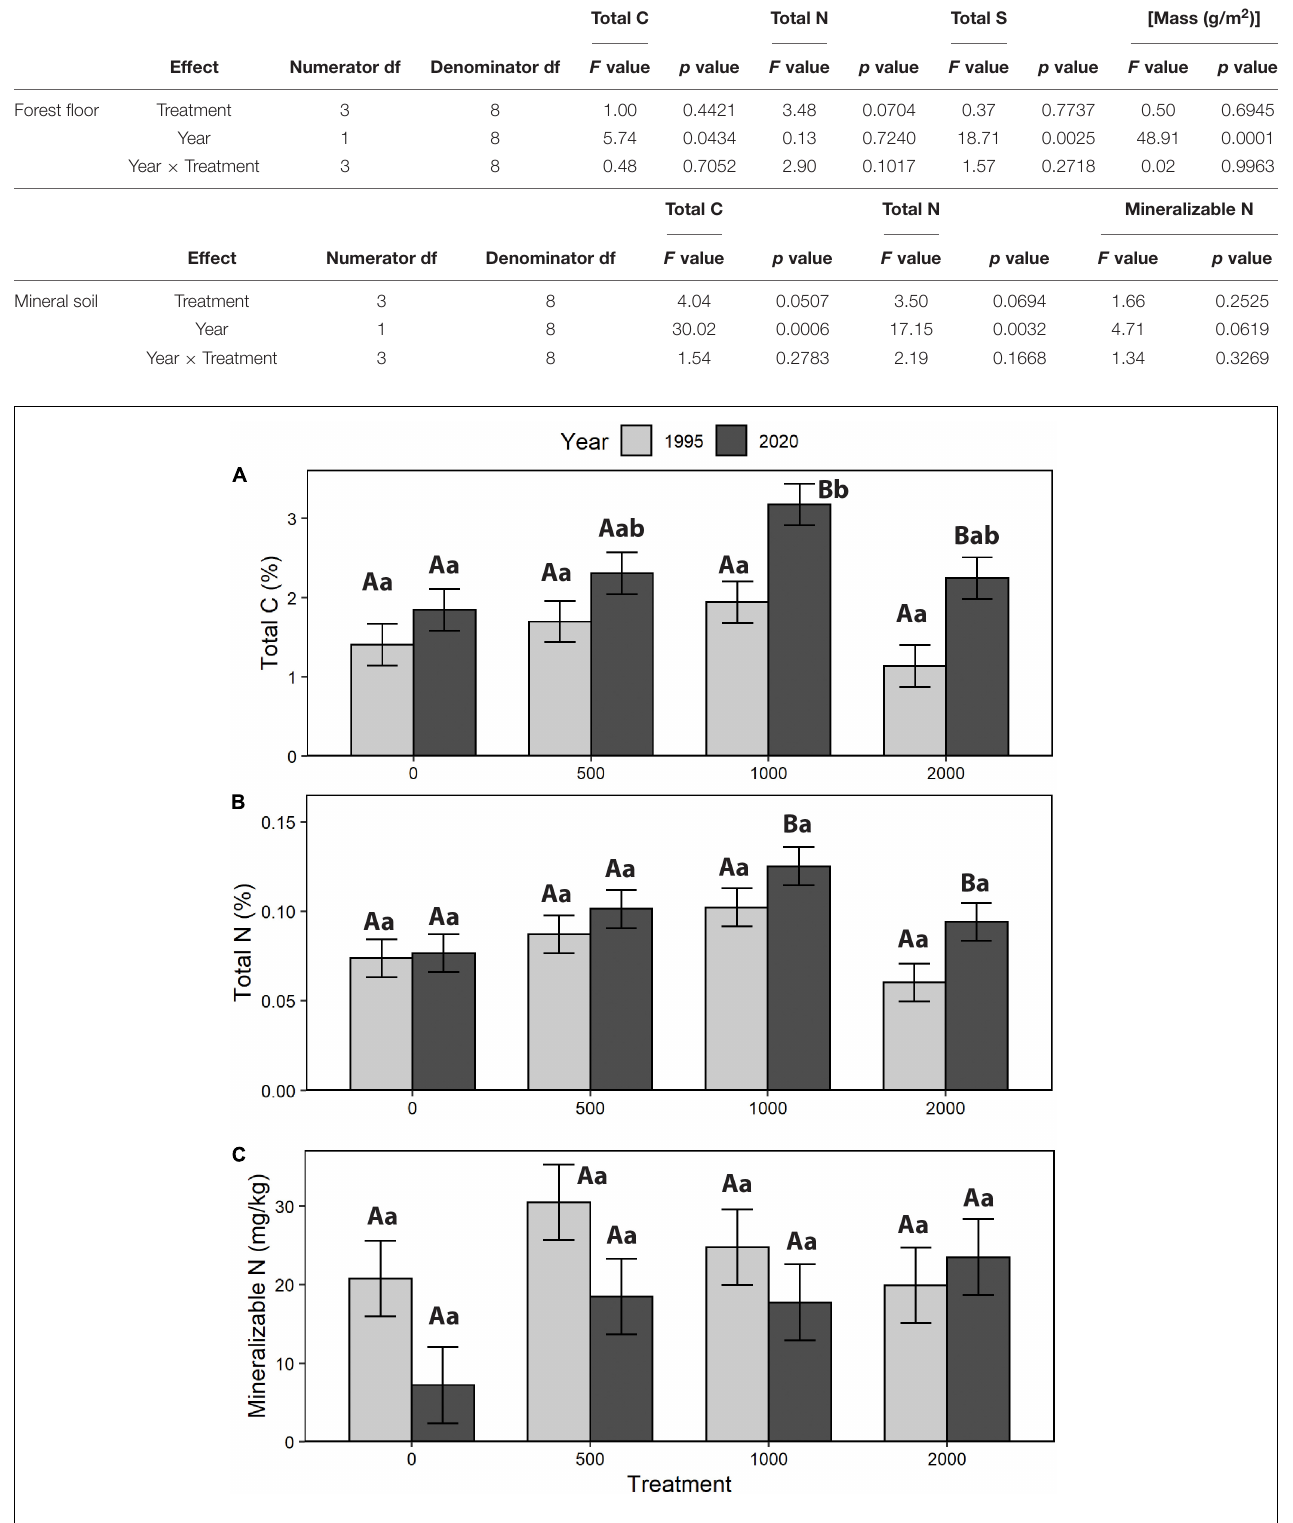
FIGURE 5 | Mineral soil change (1995–2020): (A) total carbon (C), (B) total nitrogen (N), and (C) mineralizable N (treatment means). Different letters indicate significant differences between years (A, B) or treatment within a year (a, b; p < 0.05).